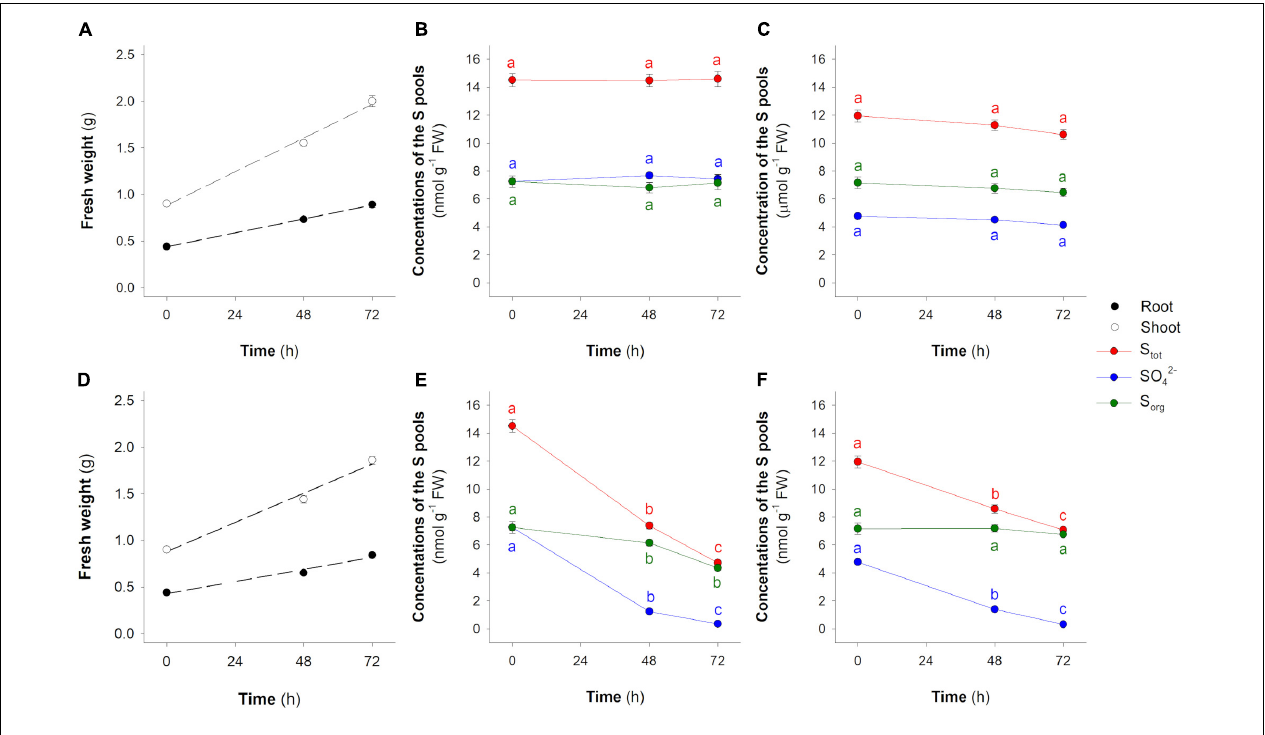
FIGURE 4 | Changes in the concentration of the S pools (S tot , SO 42 − , and S org ) in root and shoot of rice plants grown in the presence or in the absence of SO 42 − in the hydroponic solution. (A) Root and shoot fresh weight (FW) in the presence of SO 42 − . (B) S tot , SO 42 − , and S org in the root of plants grown in the presence of SO 42 − . (C) S tot , SO 42 − , and S org in the shoot of plants grown in the presence of SO 42 − . (D) Root and shoot FW in the absence of SO 42 − . (E) S tot , SO 42 − , and S org in the root of plants grown in the absence of SO 42 − . (F) S tot , SO 42 − , and S org in the shoot of plants grown in the absence of SO 42 − . Data are means ± SE of three independent experiments run in duplicate ( n = 3). Different letters indicate significant differences between the samples at different times ( P <